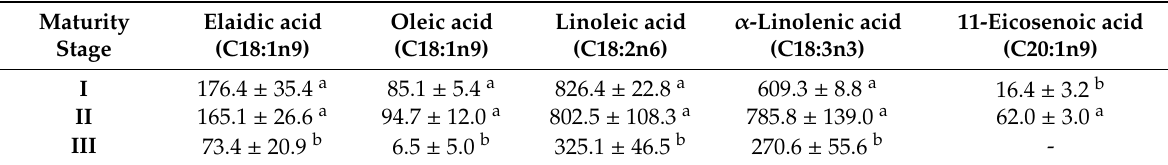
Table 4. Polyunsaturated unsaturated fatty acids (mg / 100 g d.w.) of the three maturity stages of Aloe vera flowers. Stage I: immature; stage II: mature; stage III: mature with stamens exposed to the